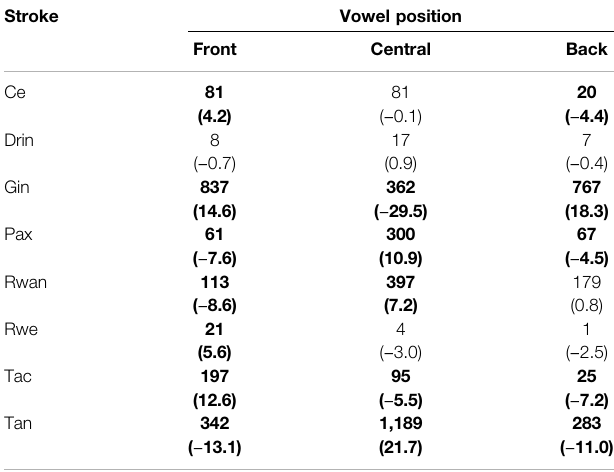
TABLE 5 | Cross-tabulation of stroke types and vowel lengths.